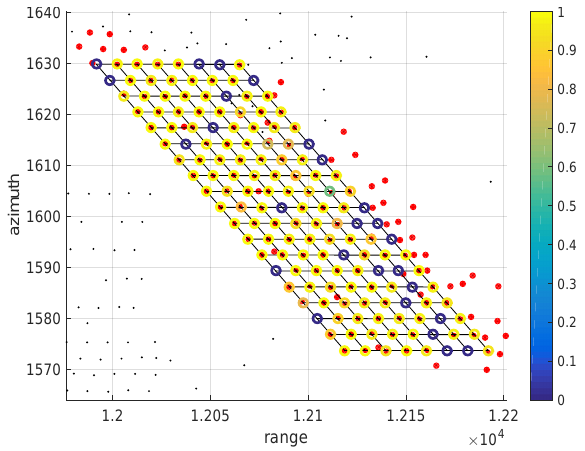
Figure 2. Exemplary result of lattice fitting in SAR data. The color of the lattice nodes encodes the reliability measure, which expresses how well a lattice point describes the closest data point, i.e. a Persistent Scatterer. All PS belonging to the facade are marked in red. Black points are PS of different facades. Some lattice nodes with values close to zero are